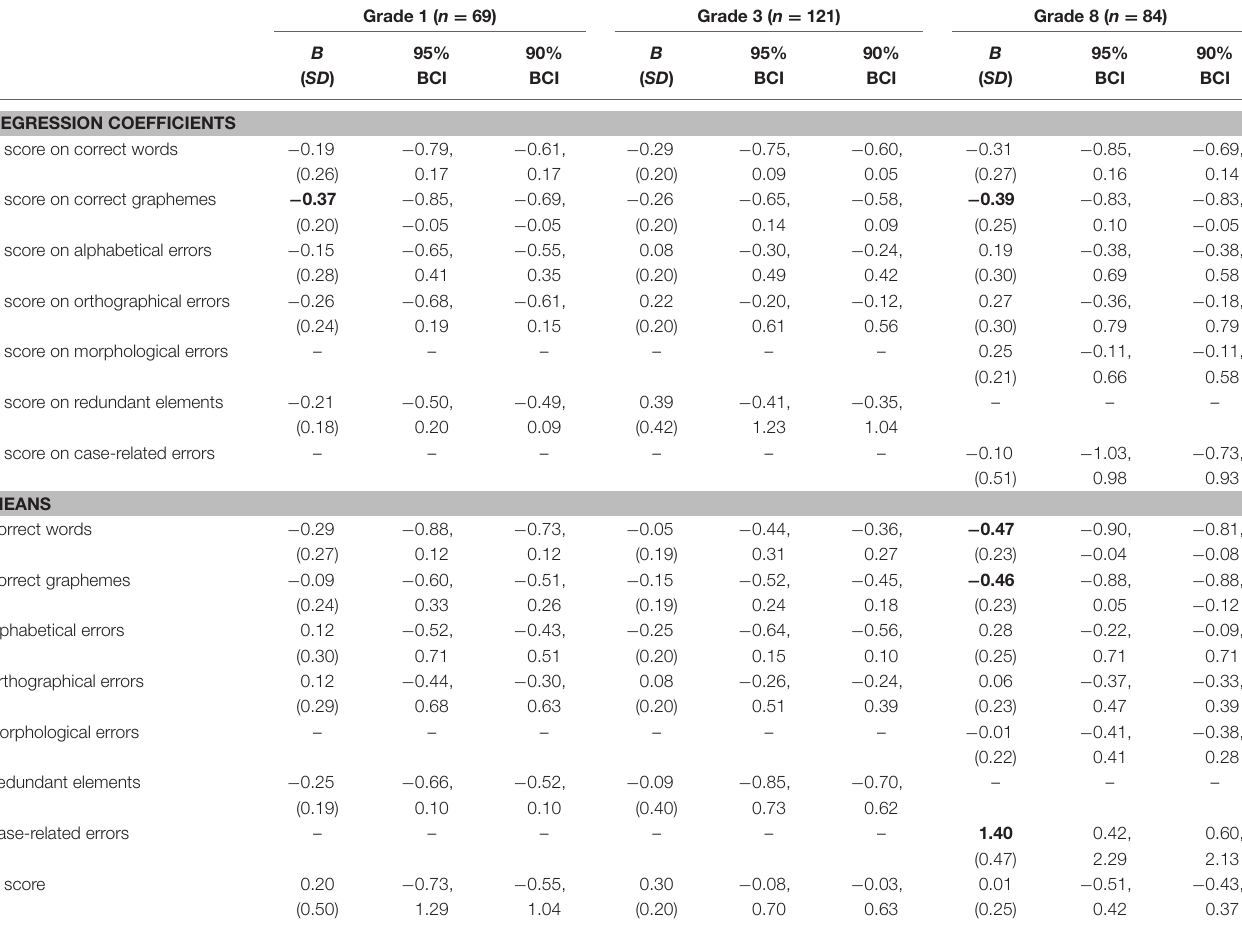
TABLE 4 | Results of difference test for structural sex invariance analyses of the full non-invariant models in grade 1, 3, and